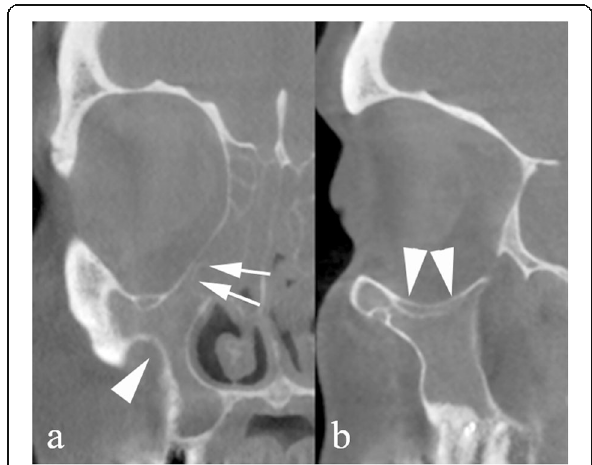
Fig. 3 Uncinate process collapse. CBCT reformations on the coronal ( a ) and sagittal ( b ) plane. The right uncinate process (arrows) lies in contact with the inferomedial orbital wall. The maxillary sinus and ethmoid infundibulum are opacified by inflamed mucosa and shrinkage of the lumen, and its walls (arrowheads) are remodeled and display an abnormally concave shape. The condition is referred to as silent sinus syndrome (mostly agger nasi cells) and by the cranial attachment of the uncinate process [6]. Some configurations (i.e., supraorbital ethmoid air cell and deep olfactory fossa) significantly influence the complexity of the procedure and may increase the relative risk of complications.